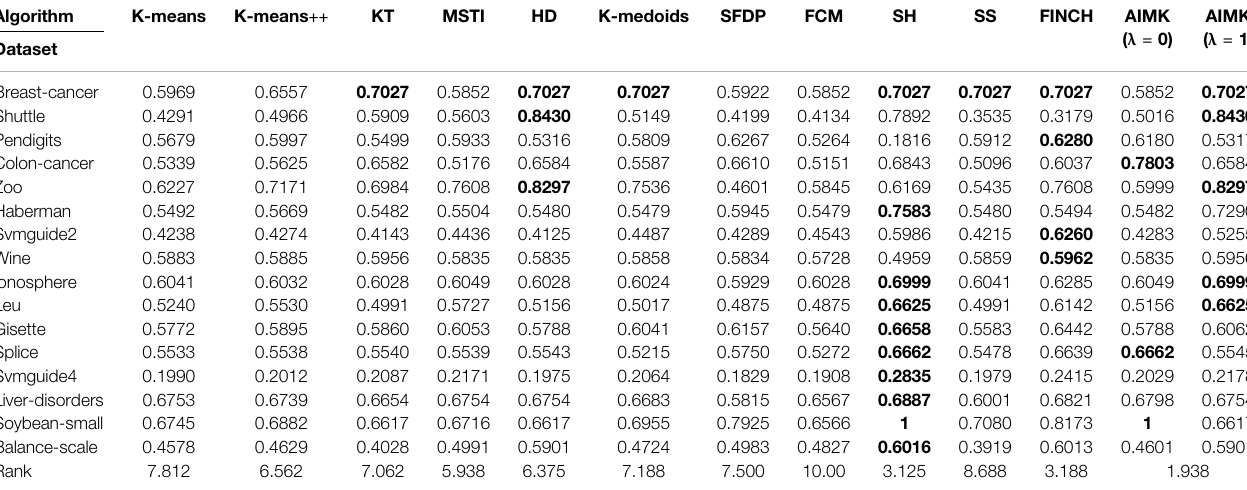
TABLE 9 | Results of All Algorithms on 16 Real-World datasets, Measured by F-Measure. Algorithm